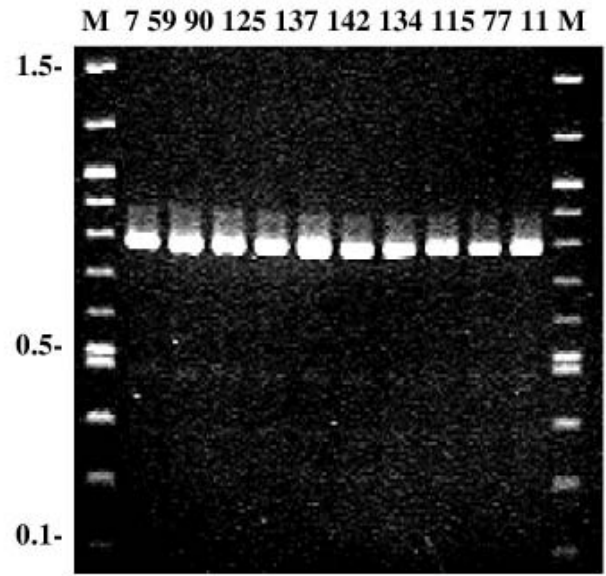
Fig. 4. ITS amplification products of different Phellinus torulosus isolates using the primer pair ITS1 and ITS4B. In the migration lanes the following are shown from left to right: M, 100 base pairs marker ladder and code of the P. torulosus isolates